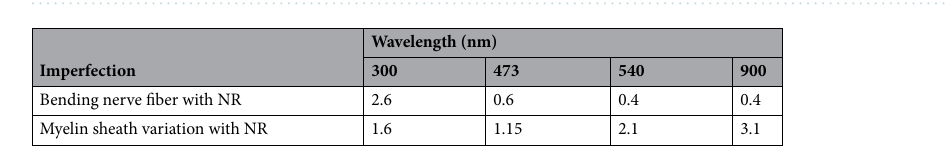
Figure 16. Distribution of the electric field in myelinated axon in the case of light launching to the myelin sheath in the presence of a Node of Ranvier with a ( a ) bending nerve fiber, ( b ) myelin sheath variation, ( c ) transmission spectra while light is launched to the myelin sheath in two states of with and without NR, and ( d ) transmission spectra in three modes of normal myelinated axon, nerve fiber with bending and myelin sheath variation in the presence of NR.